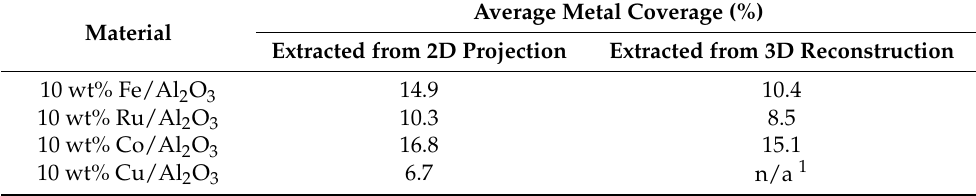
Table 3. Metal coverage, defined as ratio of the metal surface area to the total surface area, of the four different 10 wt% Al 2 O 3 -supported metal catalysts, obtained from 2D imaging and 3D processing by HAADF-STEM imaging.